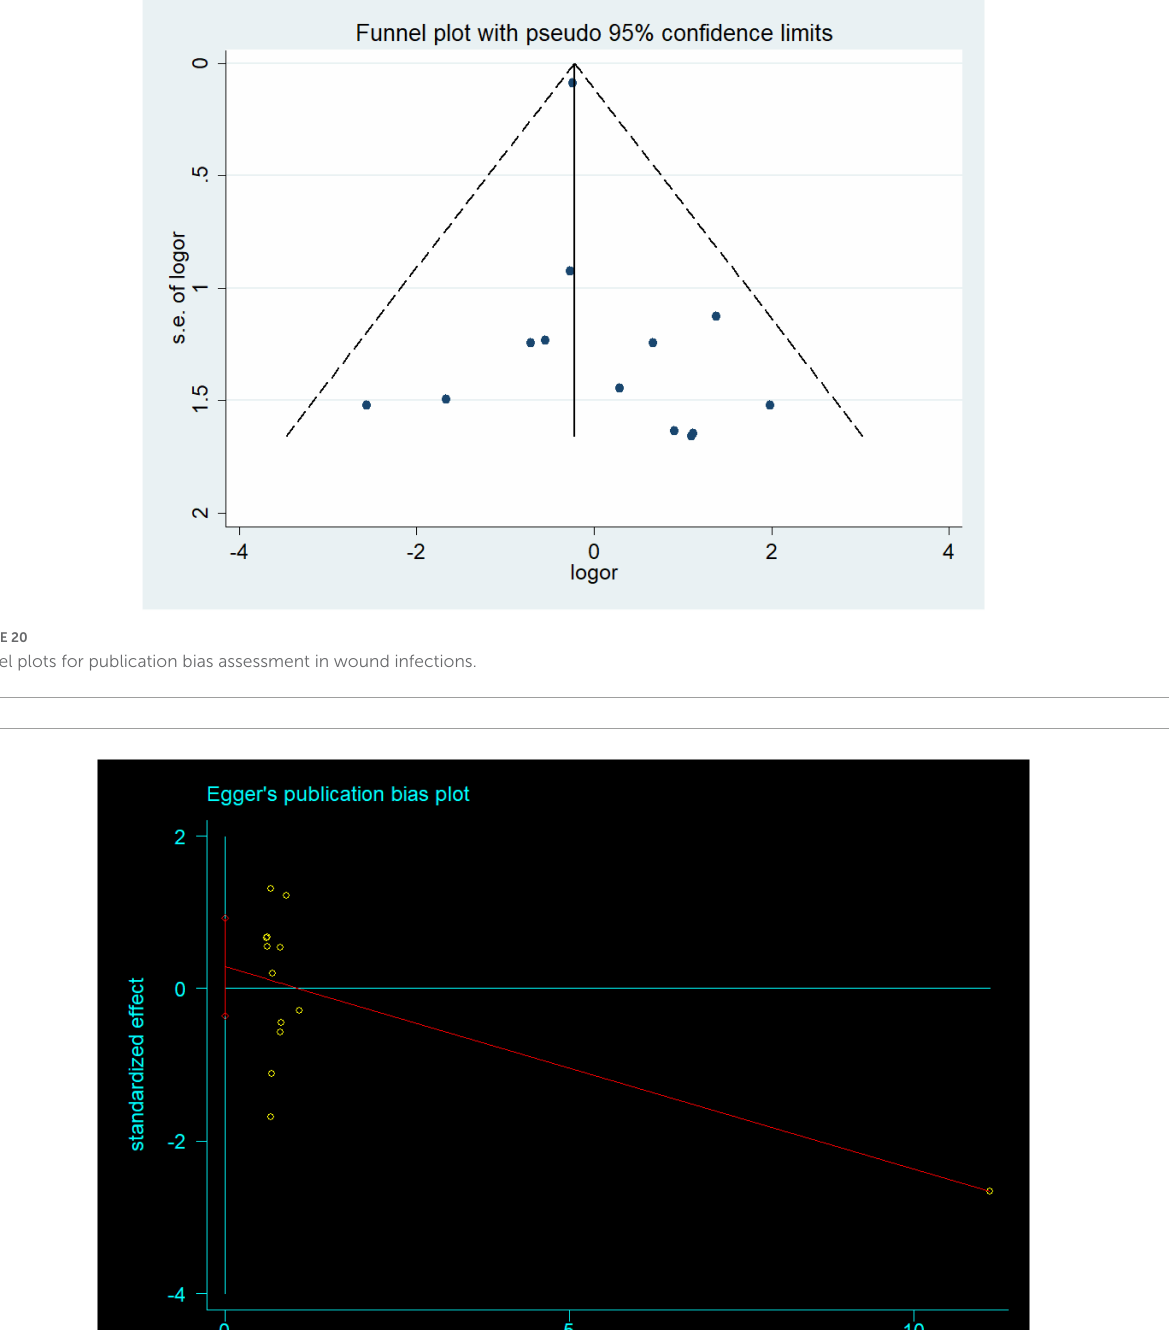
FIGURE21 Egger’s publication bias plot in wound infections.